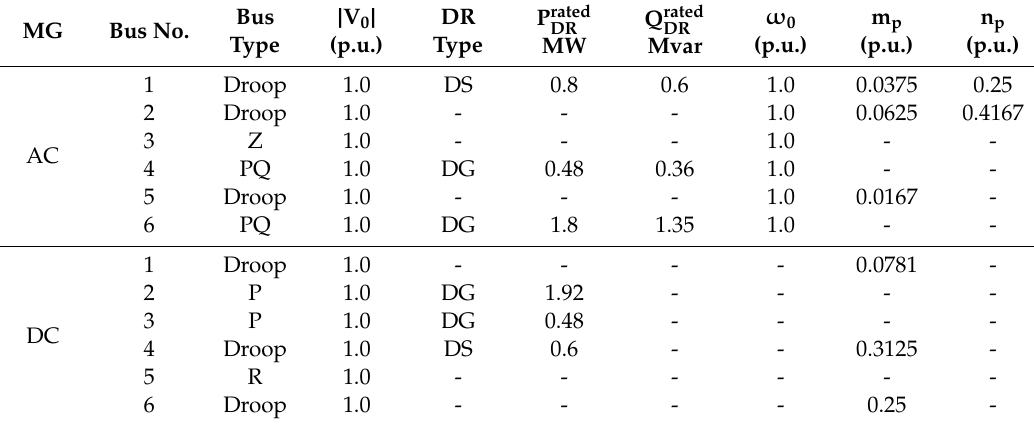
Table 9. Bus data for the 12-bus IHMG system.